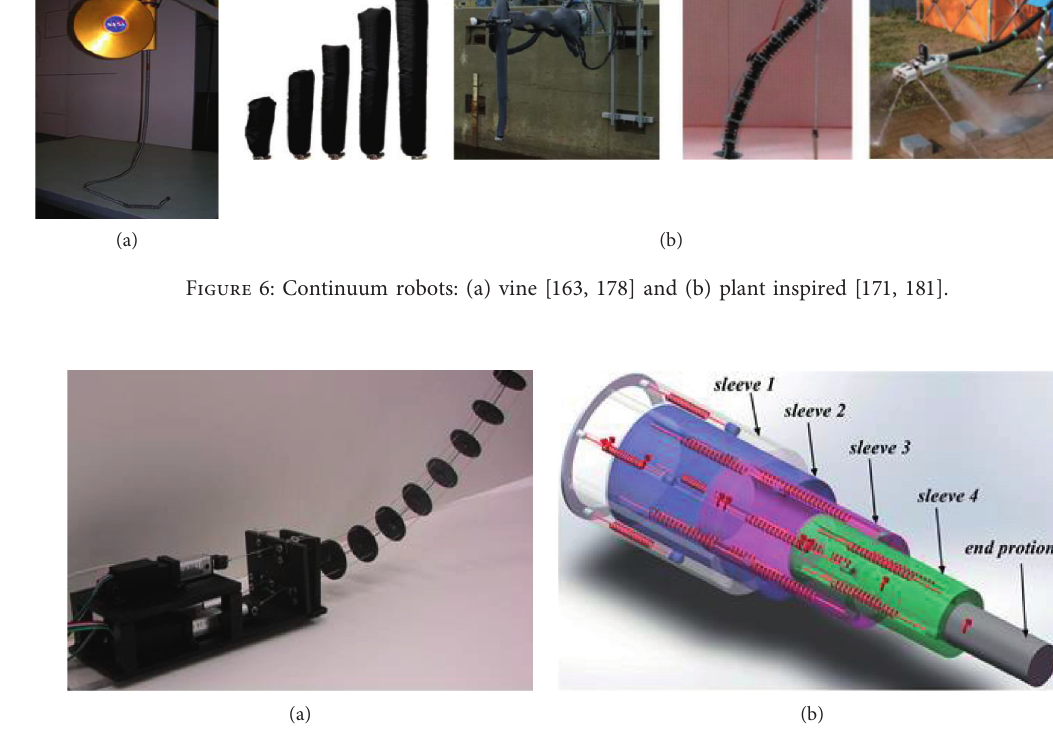
Figure 7: Continuum robots: (a) tail [182] and (b) tongue [183] inspired. Table 4: Polyamide material applications—continuum robot models.